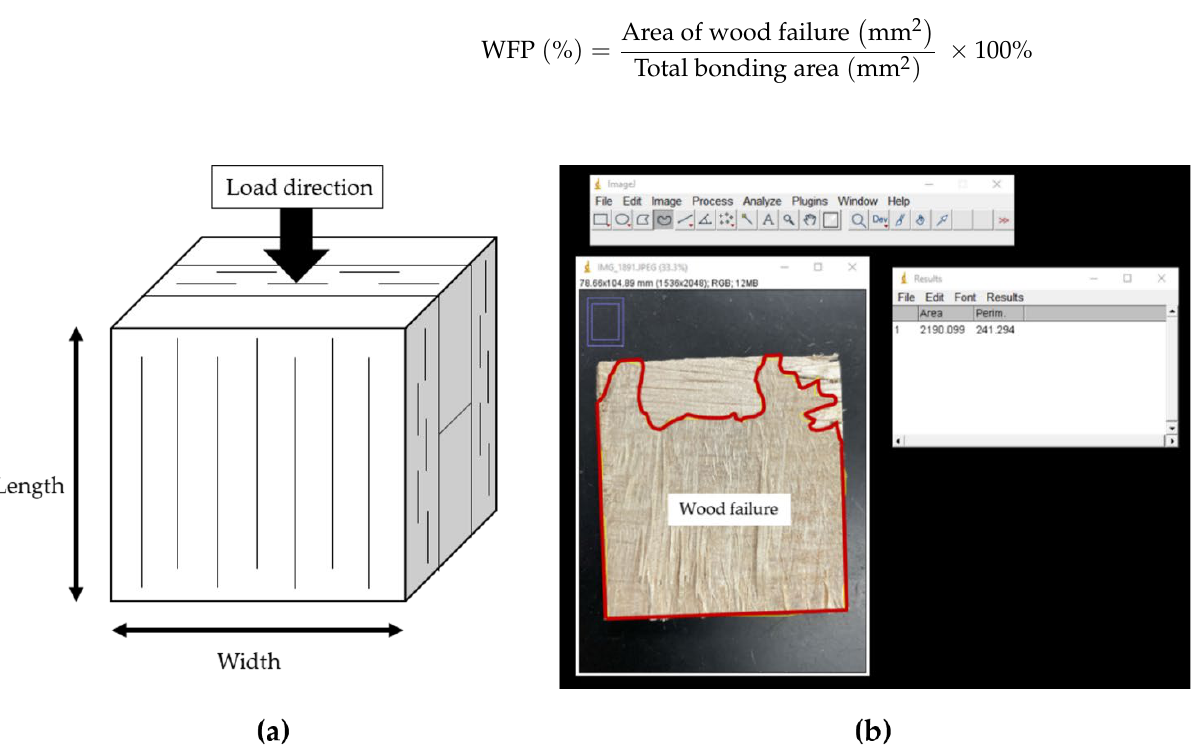
Figure 3. Area of shearing ( a ) width and length of CLT test piece accountable for area of shearing. ( b ) Measurement of area of wood failure using ImageJ software. ( b ) Measurement of area of wood failure using ImageJ